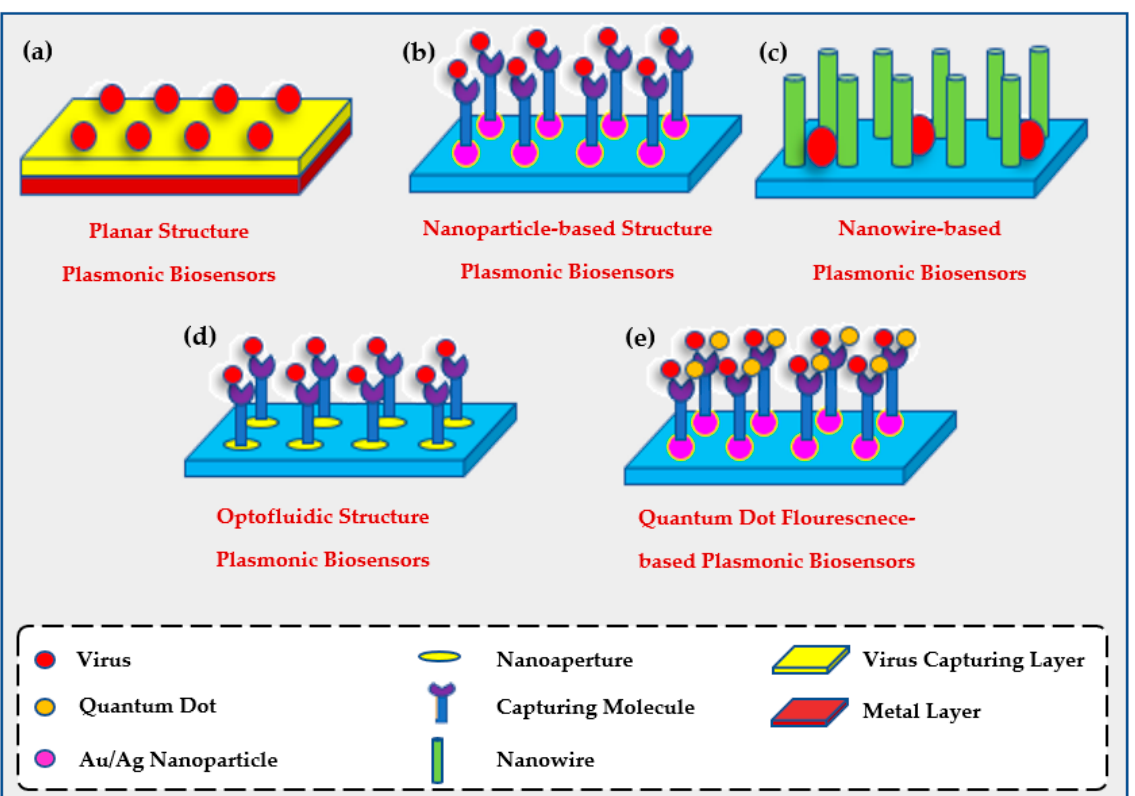
Figure 3. Common structures of plasmonic biosensors including ( a ) planar structure plasmonic bi- osensor where the base is a metal layer covered by a virus capturing layer to detect the viruses, ( b ) nanoparticle-based structure plasmonic biosensors bind to metal then a capturing molecule to cap- ture viruses, ( c ) nanowire-based plasmonic biosensors with nanowires to entrap the targeted vi- ruses, ( d ) optofluidic structure plasmonic biosensors with a virus capturing layer bind to a capturing molecule for higher detection of viruses, and ( e ) quantum dot fluorescence-based plasmonic biosen- sors with the capturing molecule bind to quantum dots which show visible changes among binding with viruses.